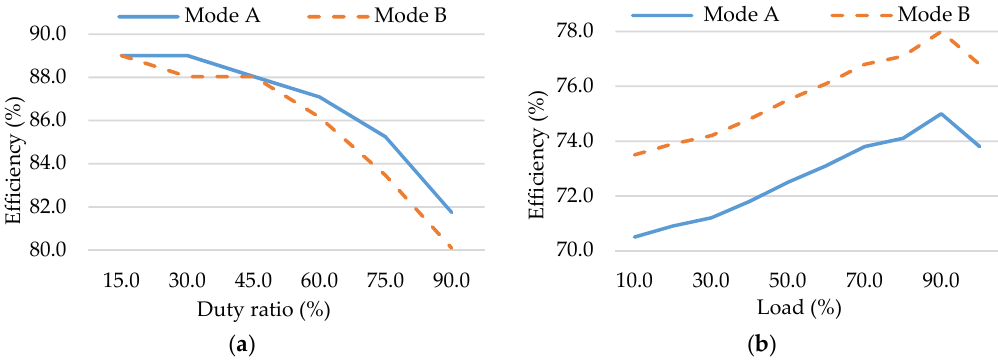
Figure 13. The efficiency results of the multiple input converter operating in Modes A and B ( a ) under varying duty cycles at a constant load and ( b ) under varying load currents at a constant output